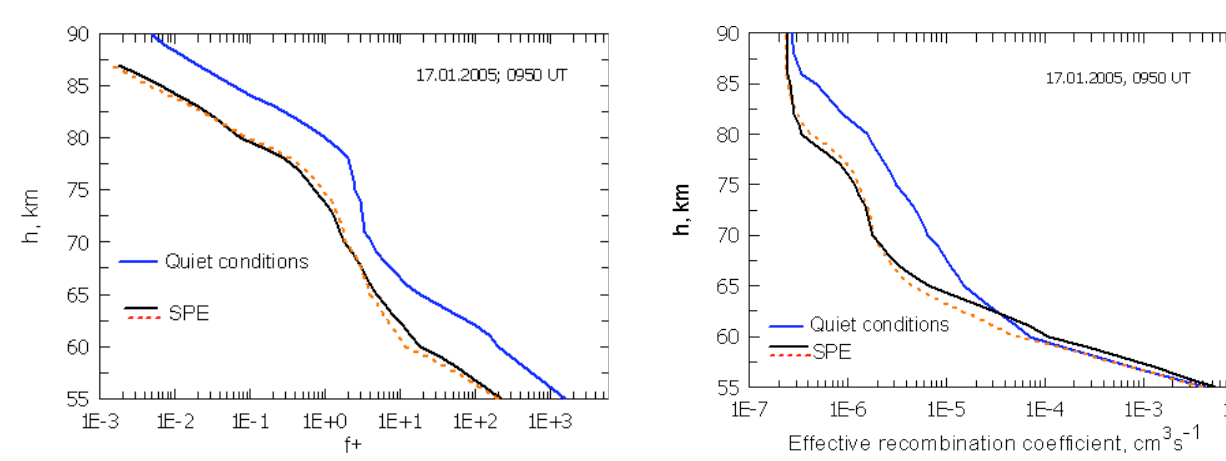
Fig. 7a. f + profiles calculated for quiet conditions (blue curve) using the O, O 3 and NO profiles 1–3 in Fig. 1 and for the SPE on 17 January 2005 at 09:50UT using profiles 4–6 in Fig. 1 (black curve) and 1–3 in Fig. 1 (red dashed curve).